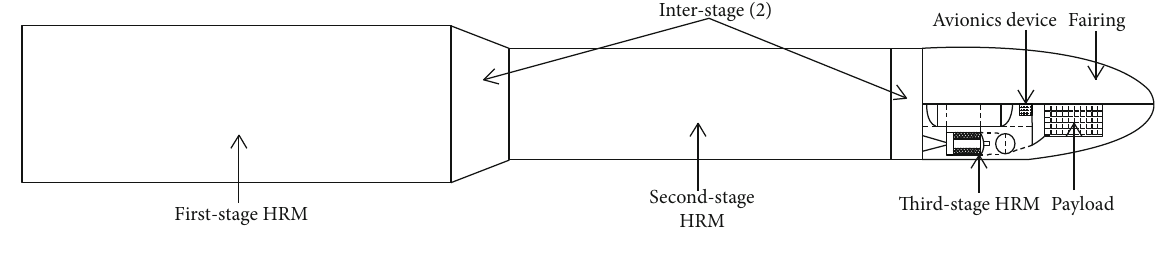
Figure 2: SLV con fi guration. Figure 5. It can be seen that the best speci fi c impulse appears when the ratio is around 4.0.